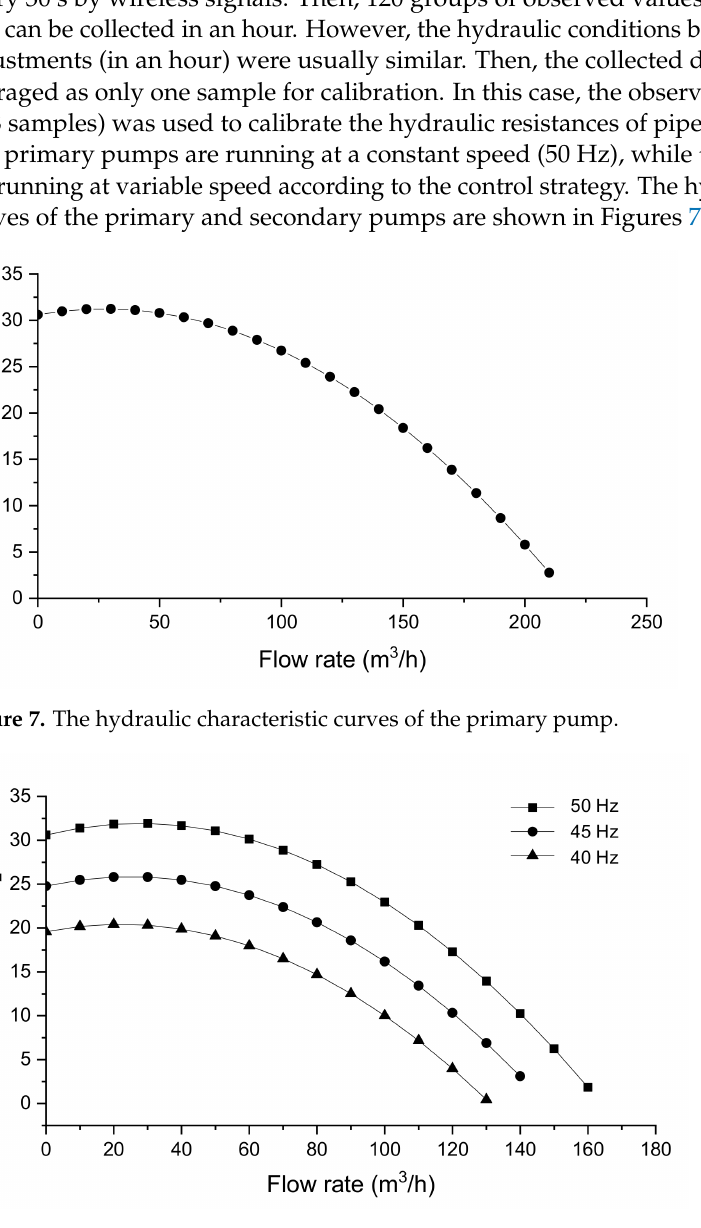
Figure 8. The hydraulic characteristic curves of the secondary